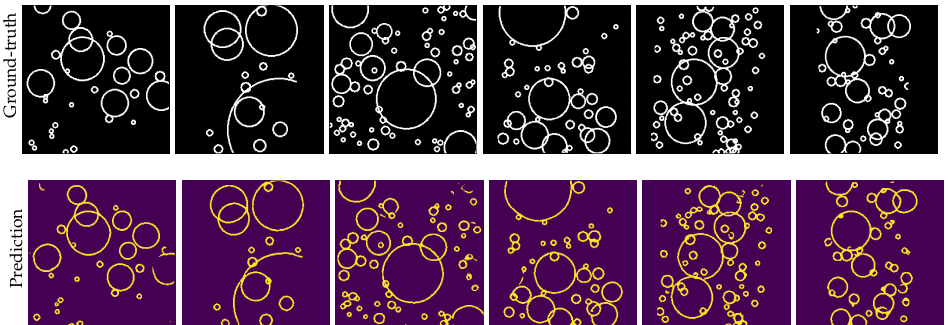
Figure 10. Crater edge segmentation prediction results based on the AFNet for the DEM data. The figure shows the ground truth of the DEM images, while the bottom figure denotes the crater edge segmentation prediction